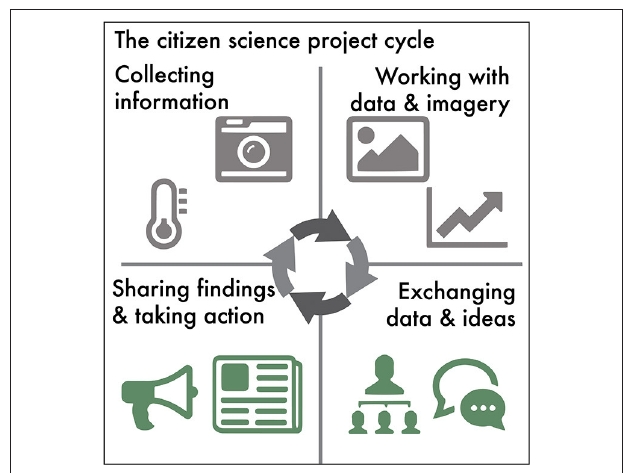
FIGURE 8 | The citizen science project cycle. For citizen science data to have broad usage and applicability at various societal levels, technology platforms need to provide more than a way to set up projects for data collection. Project participants need a way to download and work with data and imagery to